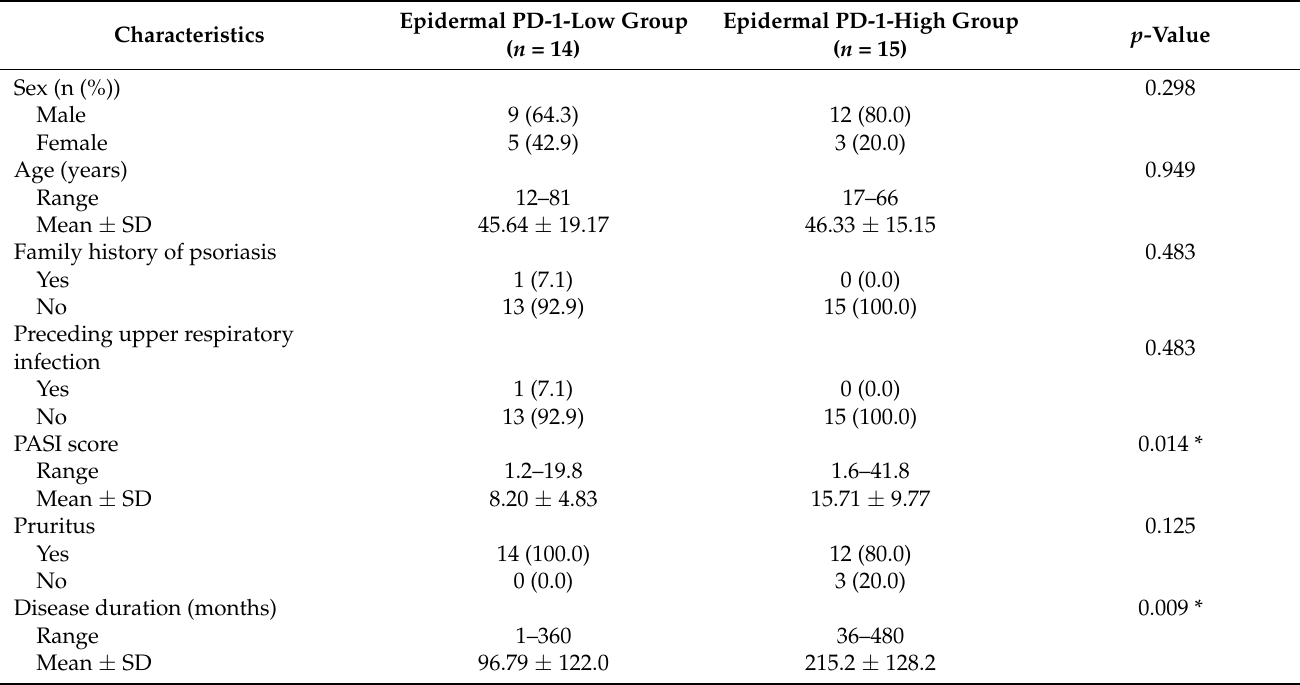
Table 1. Clinical characteristics of patients with chronic plaque psoriasis according to the epidermal expression levels of